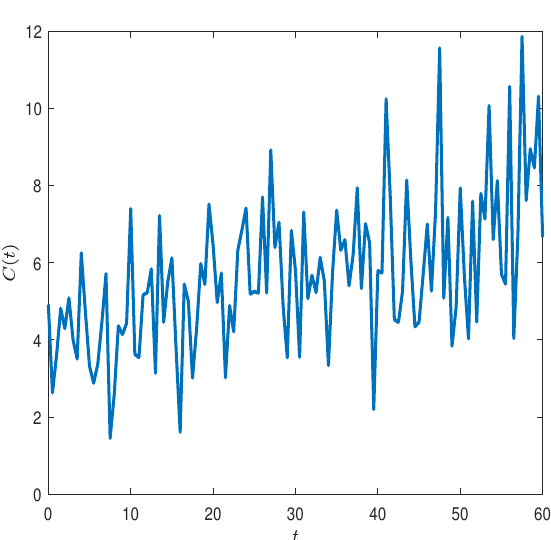
Figure 2. Optimal consumption C ( t ) as a function of t